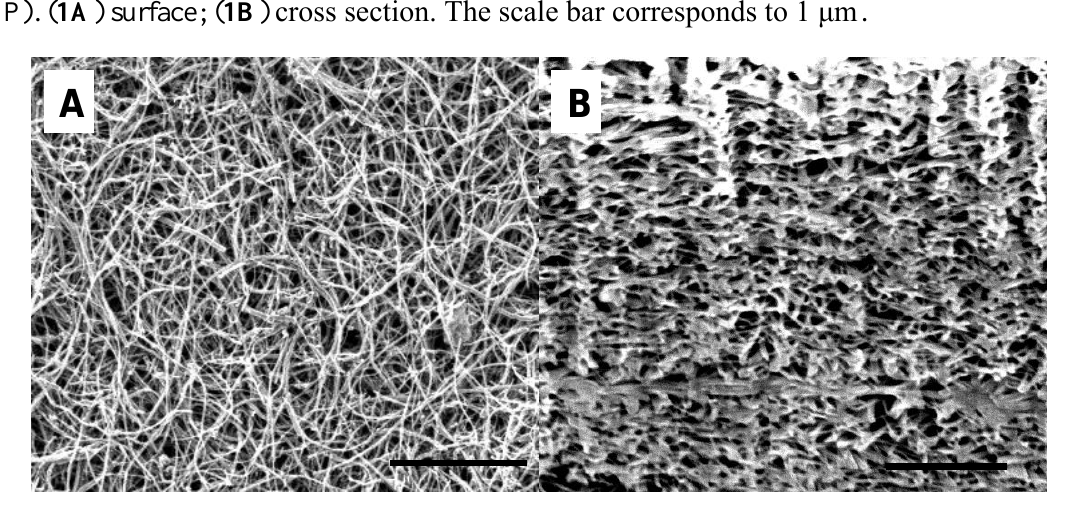
Figure 1. Scanning electron micrographs (SEM) of non bead reinforced bucky-papers (BP). ( 1A ) surface; ( 1B ) cross section. The scale bar corresponds to 1 μm.